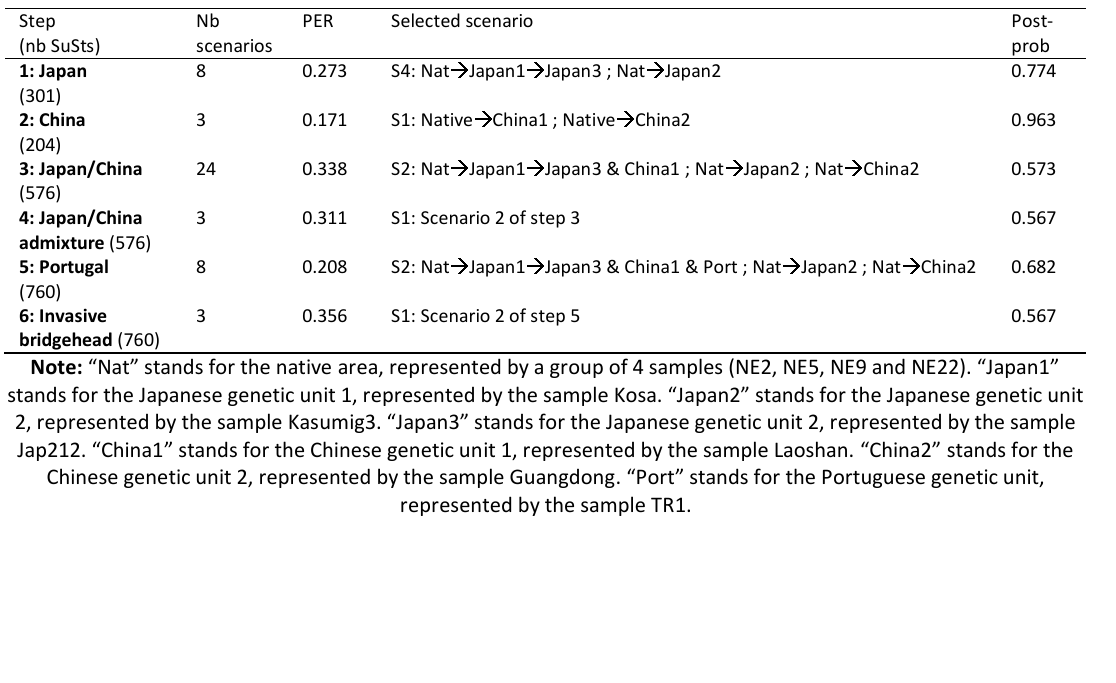
Table 3: Results of the ABC analyses carried out to infer the history of the pinewood nematode invasion. Prior error rates (PER) and posterior probabilities (post-prob) of the selected scenarios are given for the main prior set, assuming 30 generations per year. Full results for all scenarios, and all prior sets and time scales are shown in Table